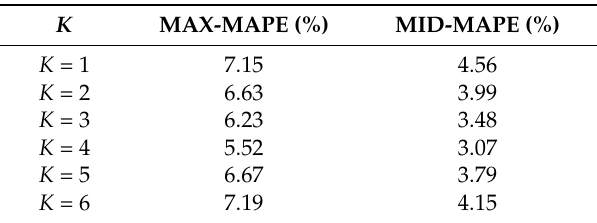
Table 4. The maximum and average MAPE of load forecasting under different clustering conditions in experiment C.